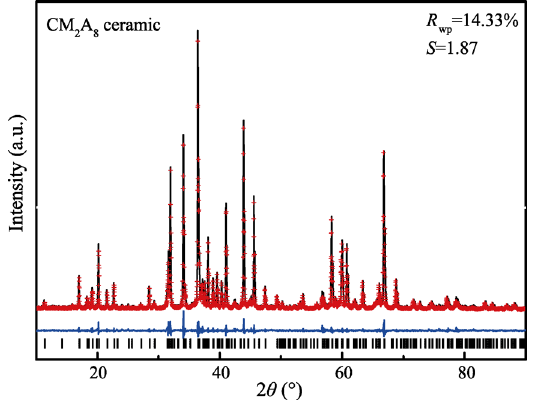
Fig. 3 Rietveld refinement of CM 2 A 8 ceramic. The red cross: computed pattern; black line: experimental data.